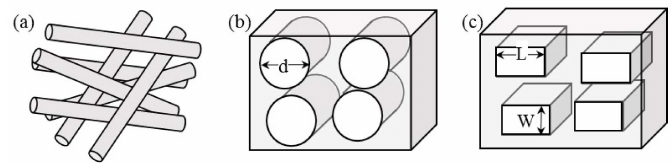
Figure 2. Schematic of different pore configurations in porous scaffolds used in tissue engineering. These are in the flow direction. ( a ) Fibrous scaffolds formed by electrospinning; ( b ) Scaffolds with nearly circular pores when formed using freeze-drying; ( c ) Scaffolds with rectangular pores when formed using salt-leaching